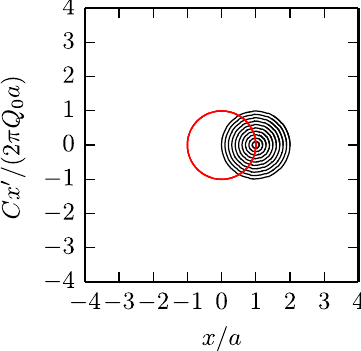
FIG. 6. Stroboscopic plot for 11 particles for two cases: the red points are for zero space charge, and the black points are for zero chromaticity. In the former case, the chromaticity tune shift Δ Q ξ is in the range of ½ − 0 . 03 ; 0 . 03 (cid:2) and all particles have zero initial amplitude with respect to the beam center, A 0 ¼ a . The latter case 0 . 05 and different initial offsets in the range ½ 0 ; a (cid:2) . is for Δ Q sc ¼ The plot contains 100 betatron periods.